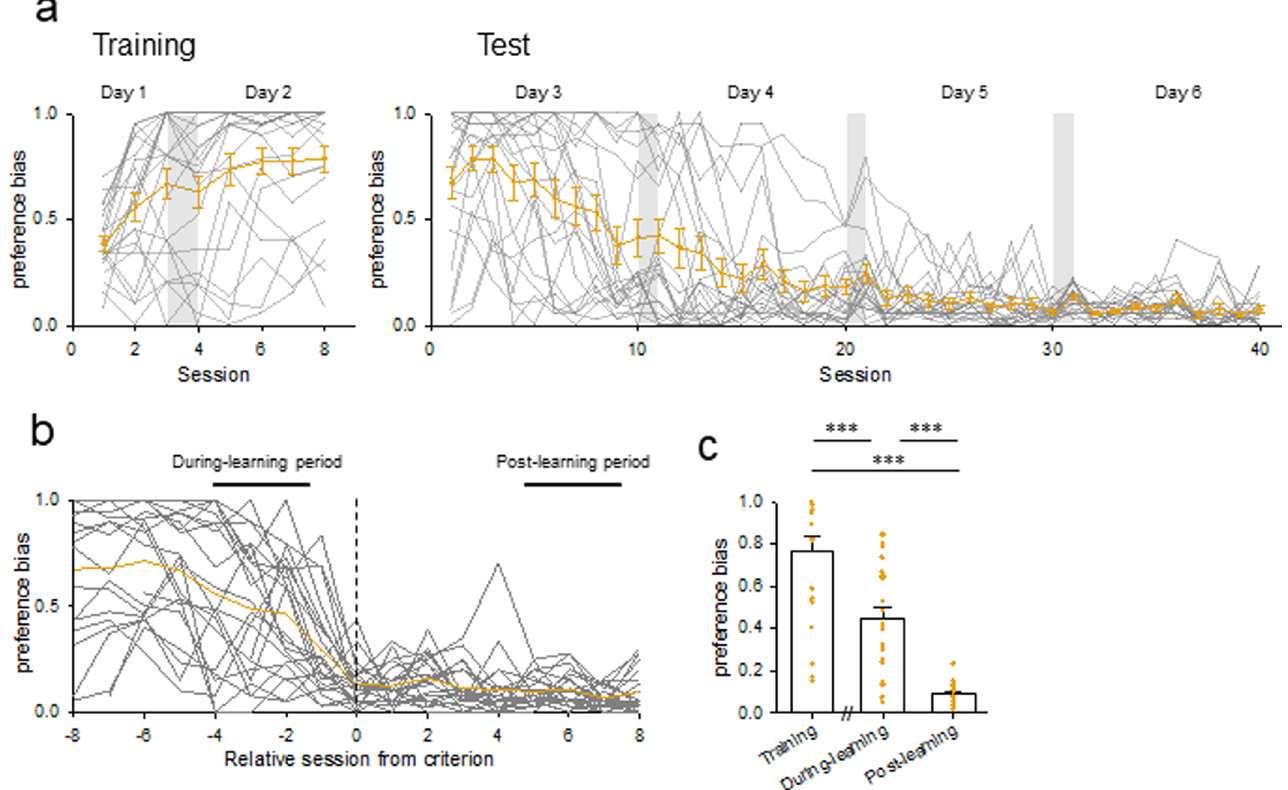
Fig 6. Preference bias during the training and test phases. (a) Time changes in the preference bias of individual 22 rats (gray lines) in the training phase ( left ) and the test phase ( right ). The yellow line indicates the means ± SEMs of 22 rats. (b) Same as (a), but they were aligned to the first session that reached the criterion. (c) Comparisons of the mean ± SEM preference biases during the training period, the during-learning period, and the post-learning period. The mean preference bias in the during-learning period was significantly lower than that in the training period and was significantly higher than that in the post-learning period. Training versus during-learning: P = 4.16 × 10 −5 , Q 3,63 = 6.66; during-learning versus post-learning: P = 5.59 × 10 −6 , Q 3,63 = 7.43; P = 1.12 × 10 −13 , F 2,63 = 49.7; Tukey’s test after one-way